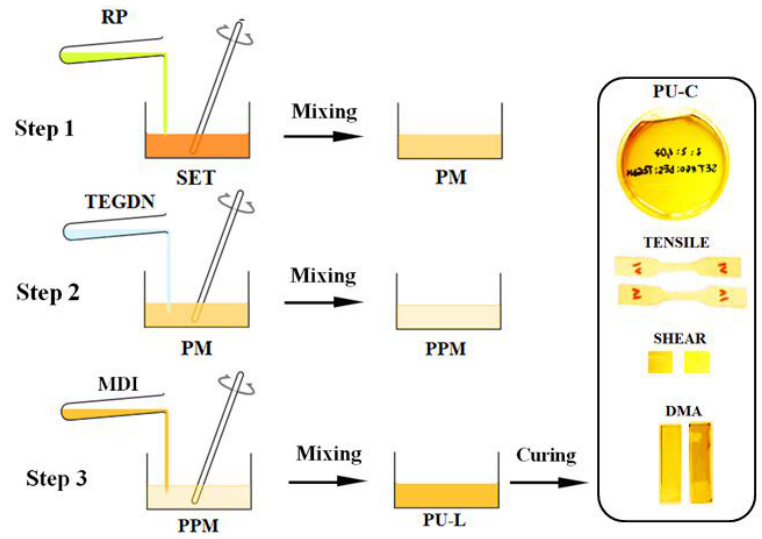
Scheme 1. Schematic presentation of the synthesis and curing of the polyurethane binders (PM: polyols mixture; PPM: plasticizer-polyols mixture; PU-L: polyurethane liquid state; PU-C: polyurethane cured state).